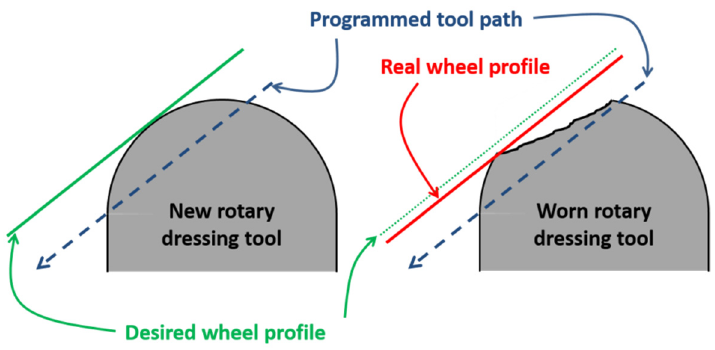
Figure 2. Influence of the worn rotary dressing tool on the wheel profile.